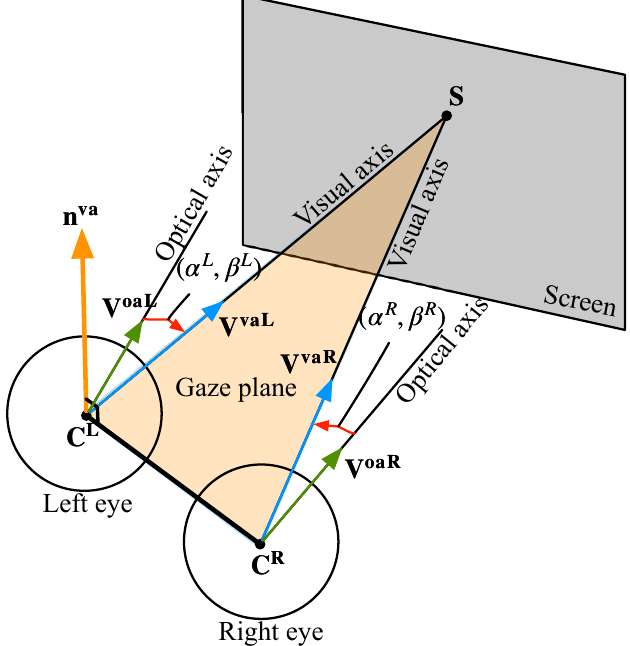
Figure 4. Binocular gaze